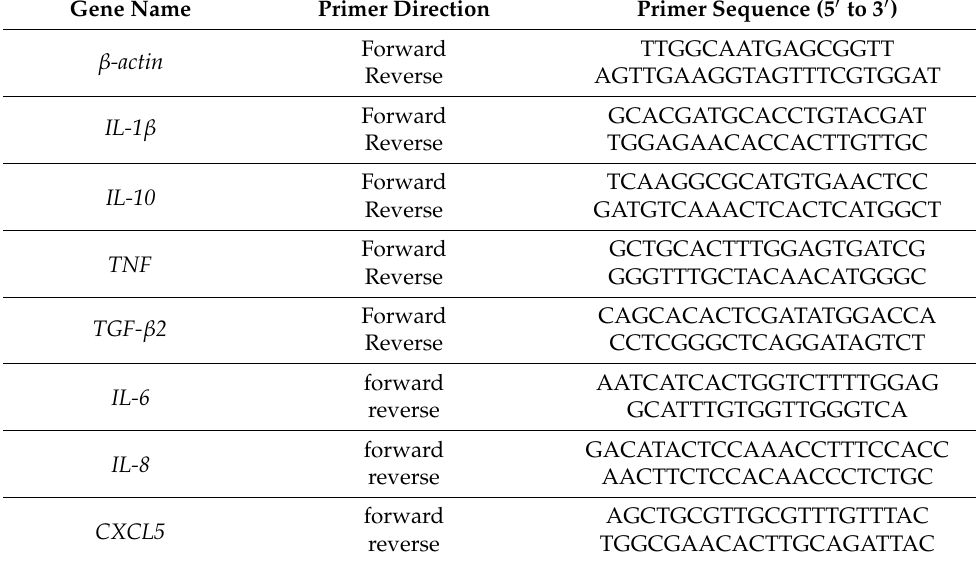
Table 1. Primer sequences used for